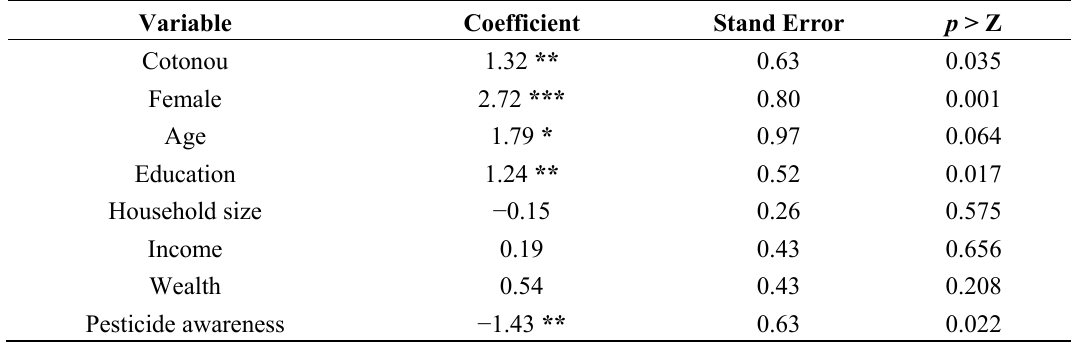
Table 4. Results of the ordered probit model (N =